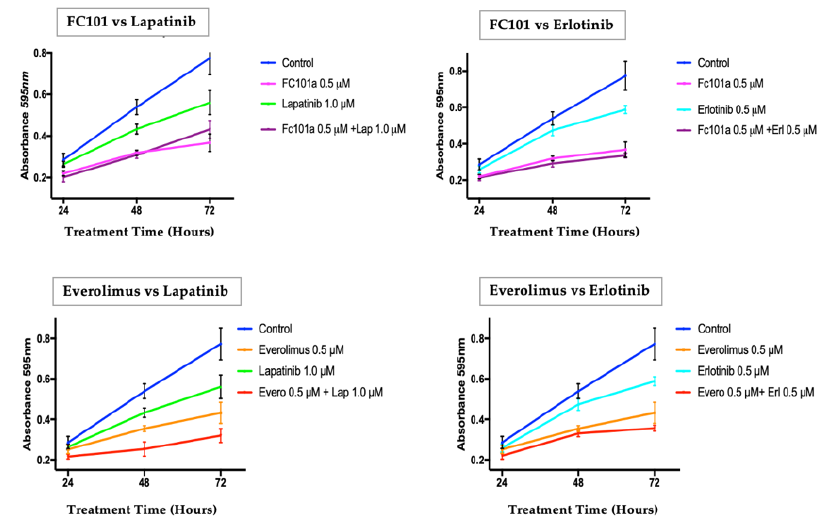
Figure 3. Crystal violet staining assay time response curve. Treatment concentrations included FC101 (0.5 μM), lapatinib (1.0 μM), erlotinib (0.5 μM), everolimus (0.5 μM), and combinations of FC101 or everolimus with lapatinib or erlotinib. The graph represents normalized A 595 (% control) vs. time course treatments at 24, 48, and 72 h.